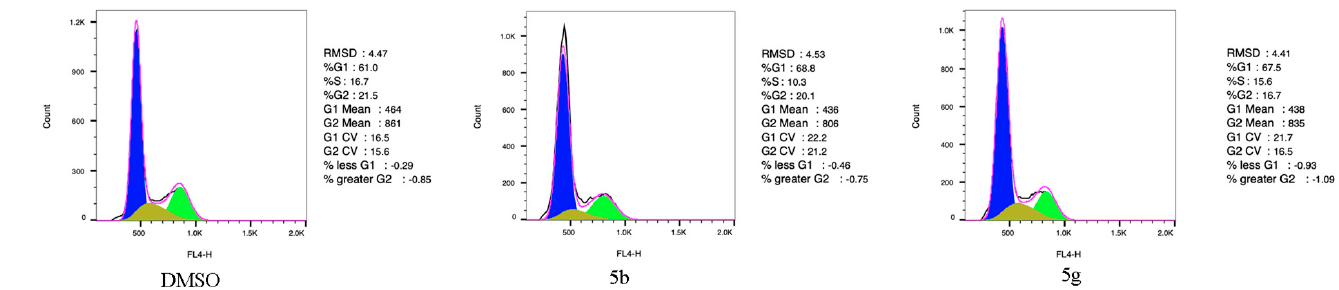
Figure 4. Cell cycle analysis of the HL60 cells treated with compound 5b and 5g for 24 h using flow